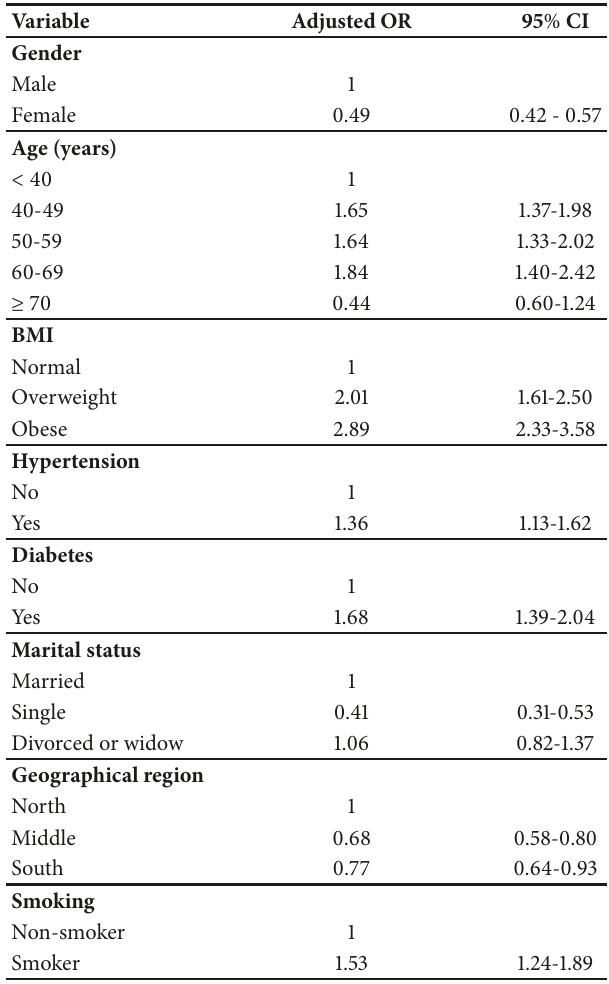
Table 2: Adjusted odds ratios and their 95% Cl for Hypercholes- terolemia using multivariate logistic regression, Jordan 2017.